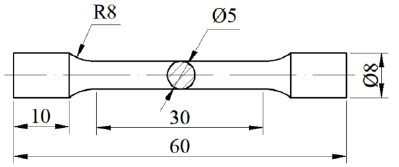
Figure 2. Schematic of tensile samples (unit: mm).